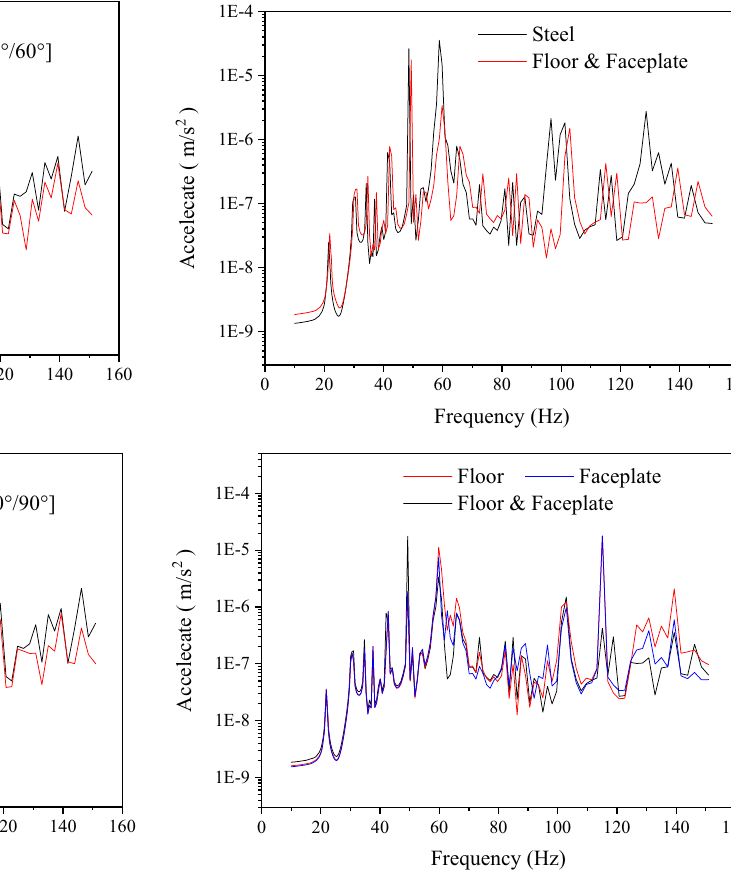
Figure 8: In fl uence of layup angle on the vibration damping performance.